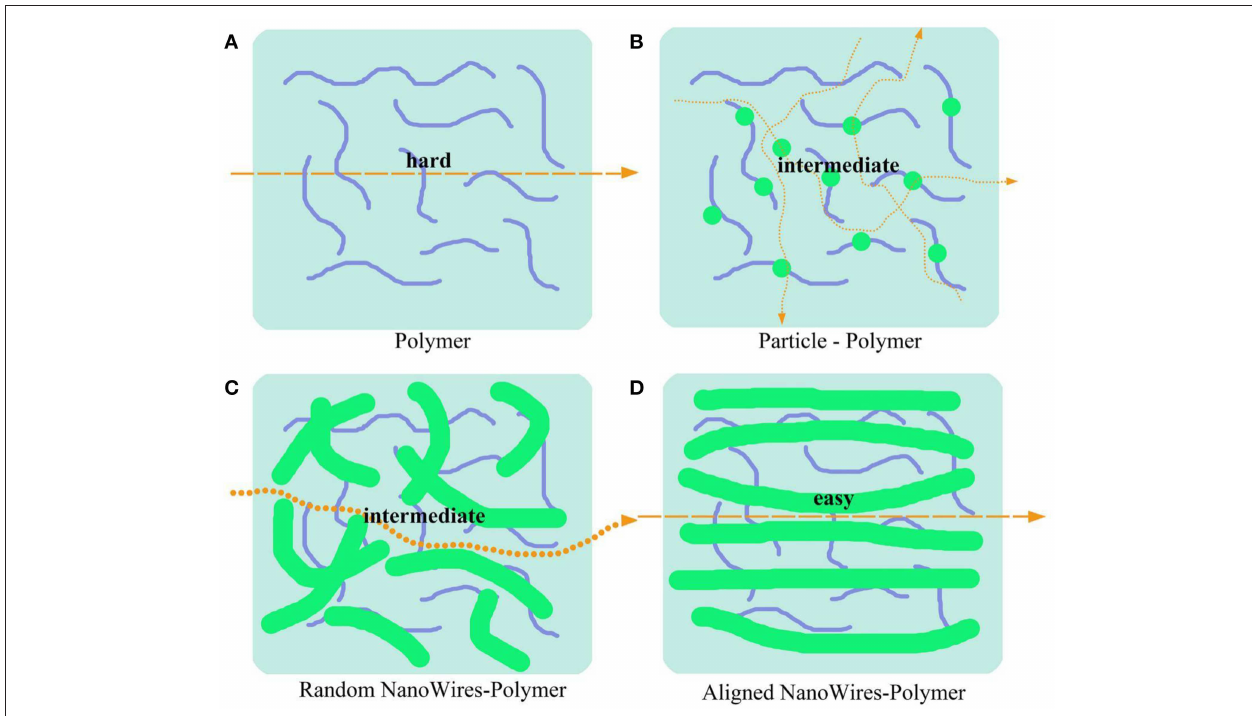
FIGURE 6 | Schematic of conduction mechanism in three kinds of morphologies solid polymer electrolytes. (A) Ionic transport path in pure polymer electrolytes. (B–D) Ionic transport path in polymer-based composite electrolytes with nanoparticles (B) , random nanowires (C) and aligned nanowires (D) .